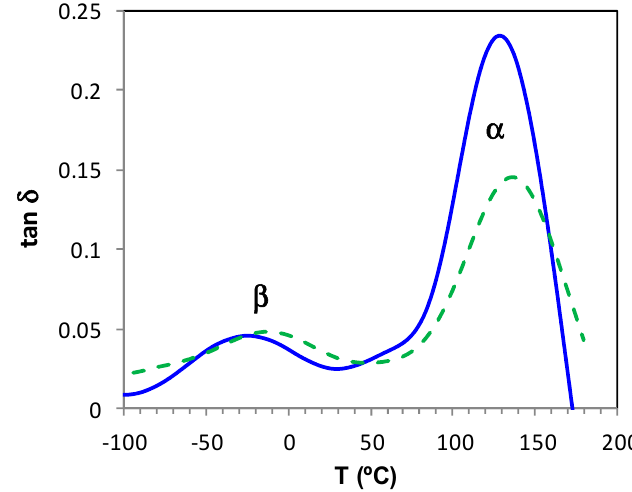
Figure 16. DMA curves for the fully cured ELP800 (full line) and ELP25000 (dashed line), systems at 5 Hz and 2 °C/min.